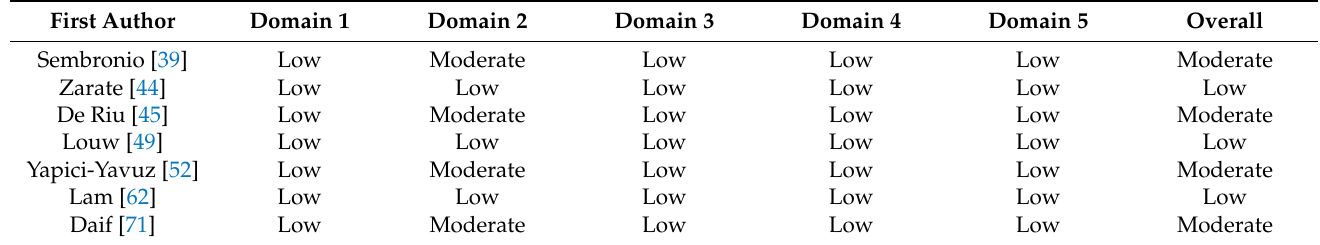
Table 4. Risk of bias assessment: Domain 1—Risk of bias arising from the randomization process; Domain 2—Risk of bias due to deviations from the intended interventions; Domain 3—Missing outcome data; Domain 4—Risk of bias in measurement of the outcome; Domain 5—Risk of bias in selection of the reported result; Overall—Overall risk of